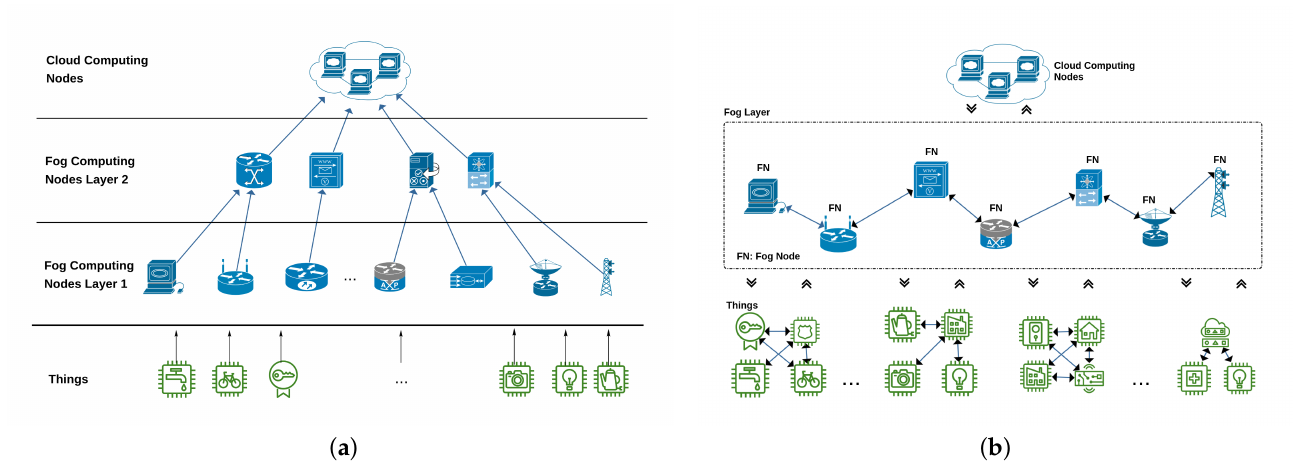
Figure 1. ( a ) Vertical Fog architecture. ( b ) Horizontal Fog